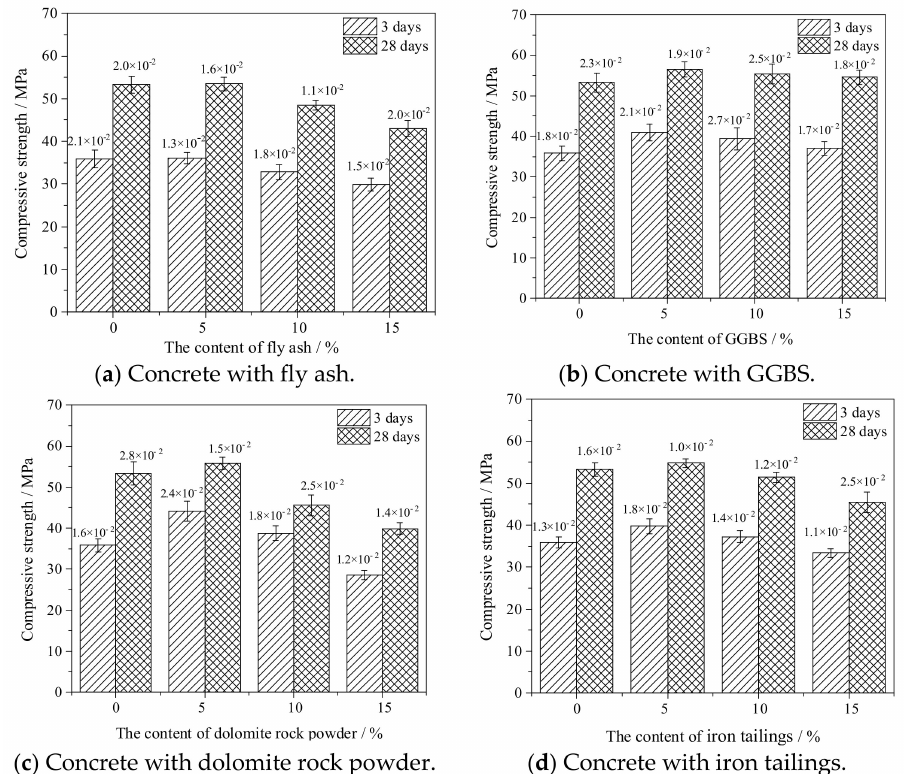
Figure 3. Compressive strength of